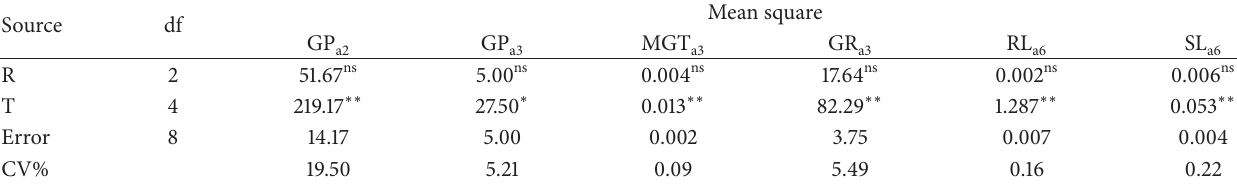
Table 1: Variance analysis of the different exposure times of microwave frequency effects on the measured traits in MR 219 rice variety. Source df